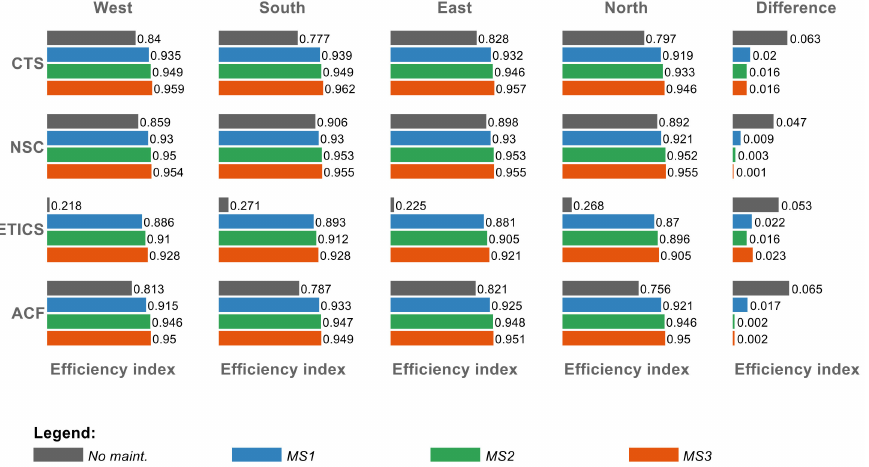
Figure 15. Comparison of the efficiency index according to orientation for a time horizon of 80 years.